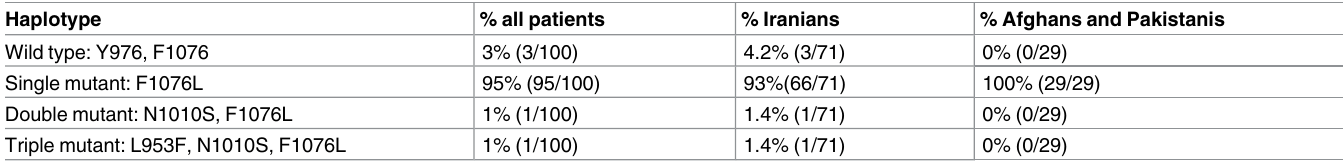
Table 2. Summaryof Pvmdr1